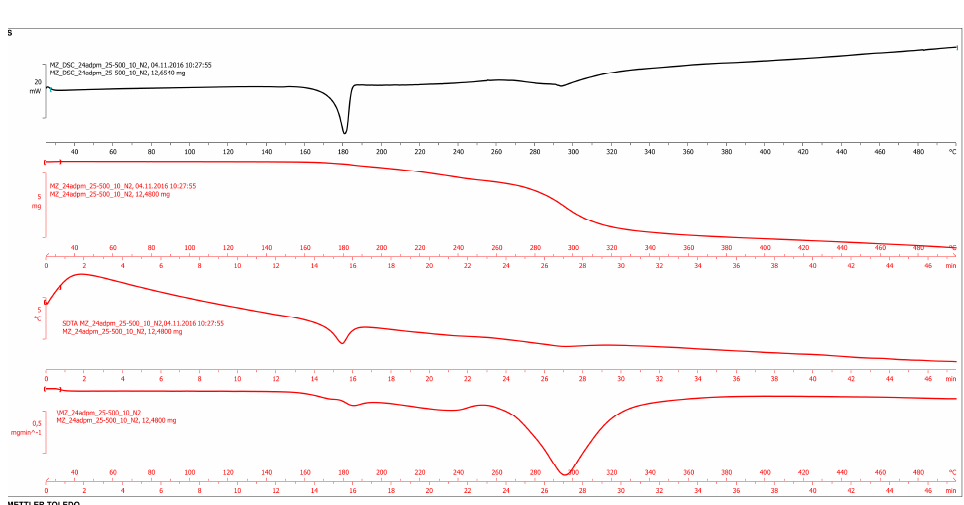
Figure C3. DSC, TG, SDTA and DTG curves of mOHsaladpm .